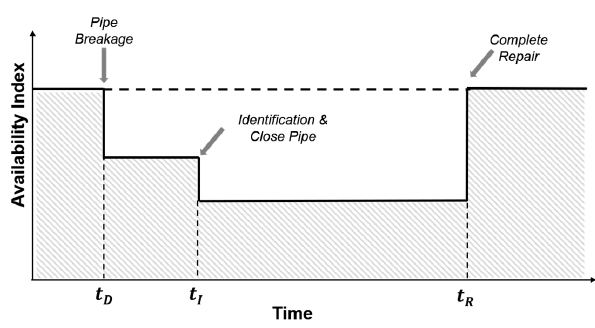
Figure 1. Availability index variation to simulation time and condition.